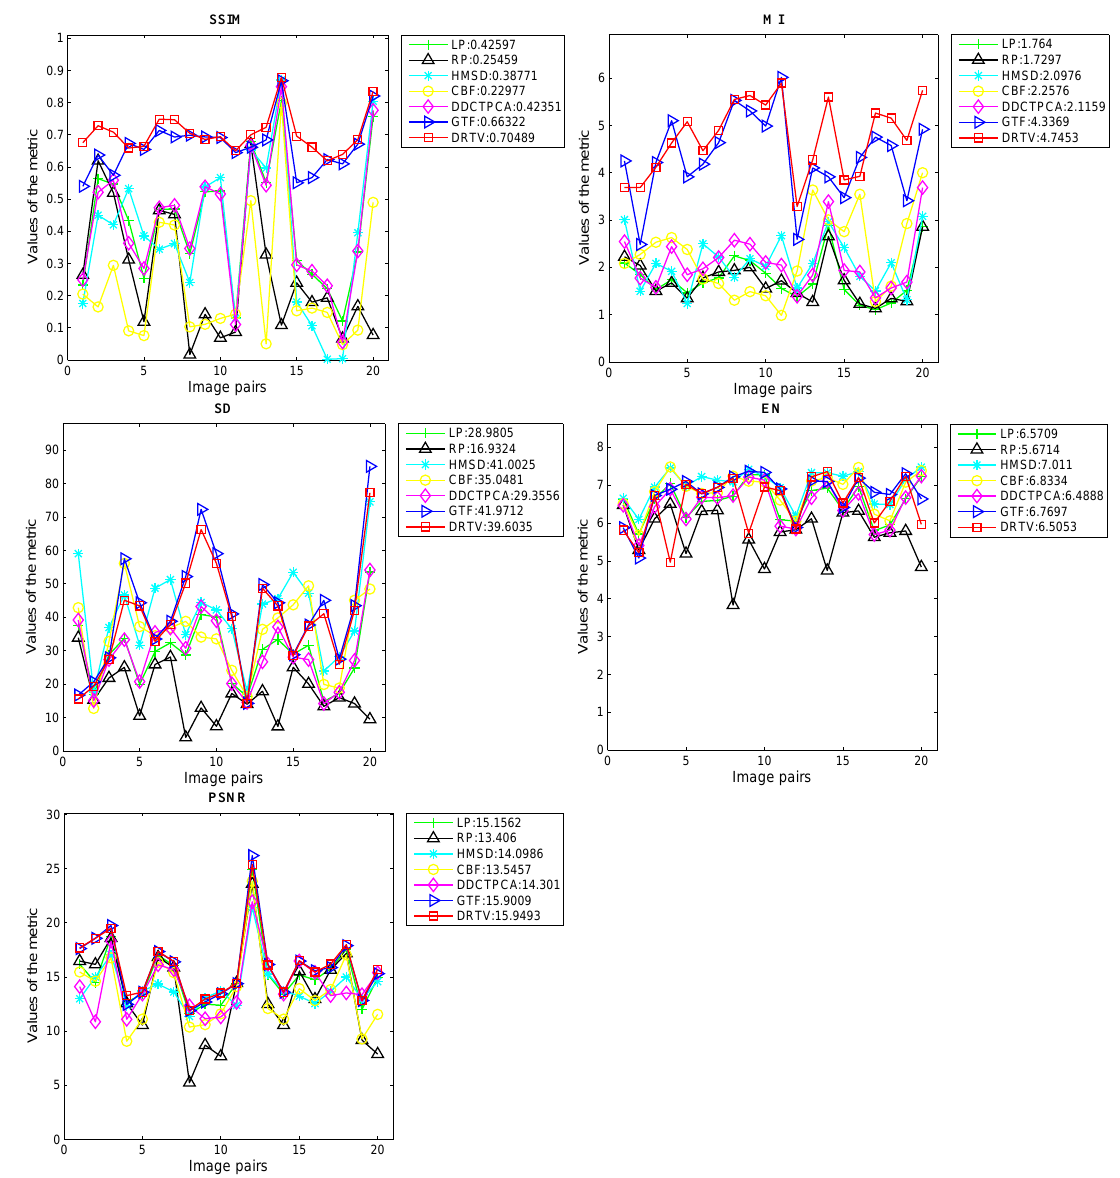
Figure 3. Quantitative comparisons of six fusion methods on twenty image